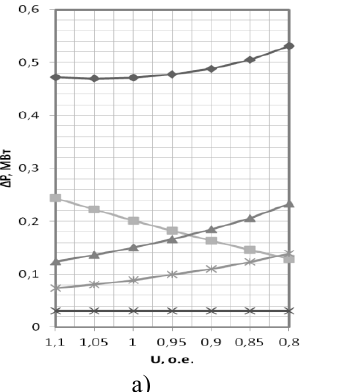
Fig. 4.Statistical characteristics of losses active power in SM: а) when Кз = 0.9; b) when Кз = 0.8 Similar structural properties were built for the TP-26 JSC "SSGPO" at Кз = 0.7, 0.6, 0.5, AM and